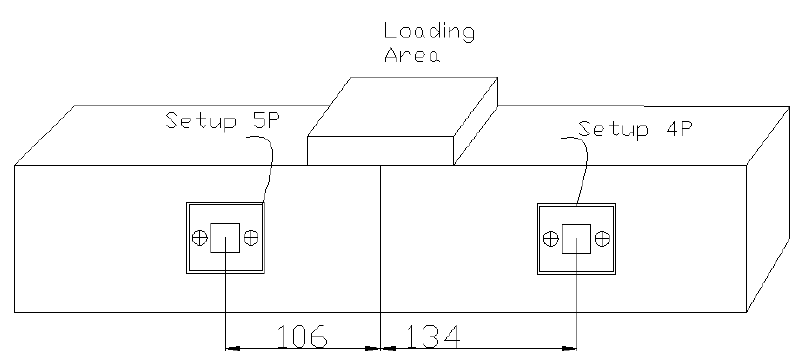
Figure 3. Cycling loading setup for Cast 7.